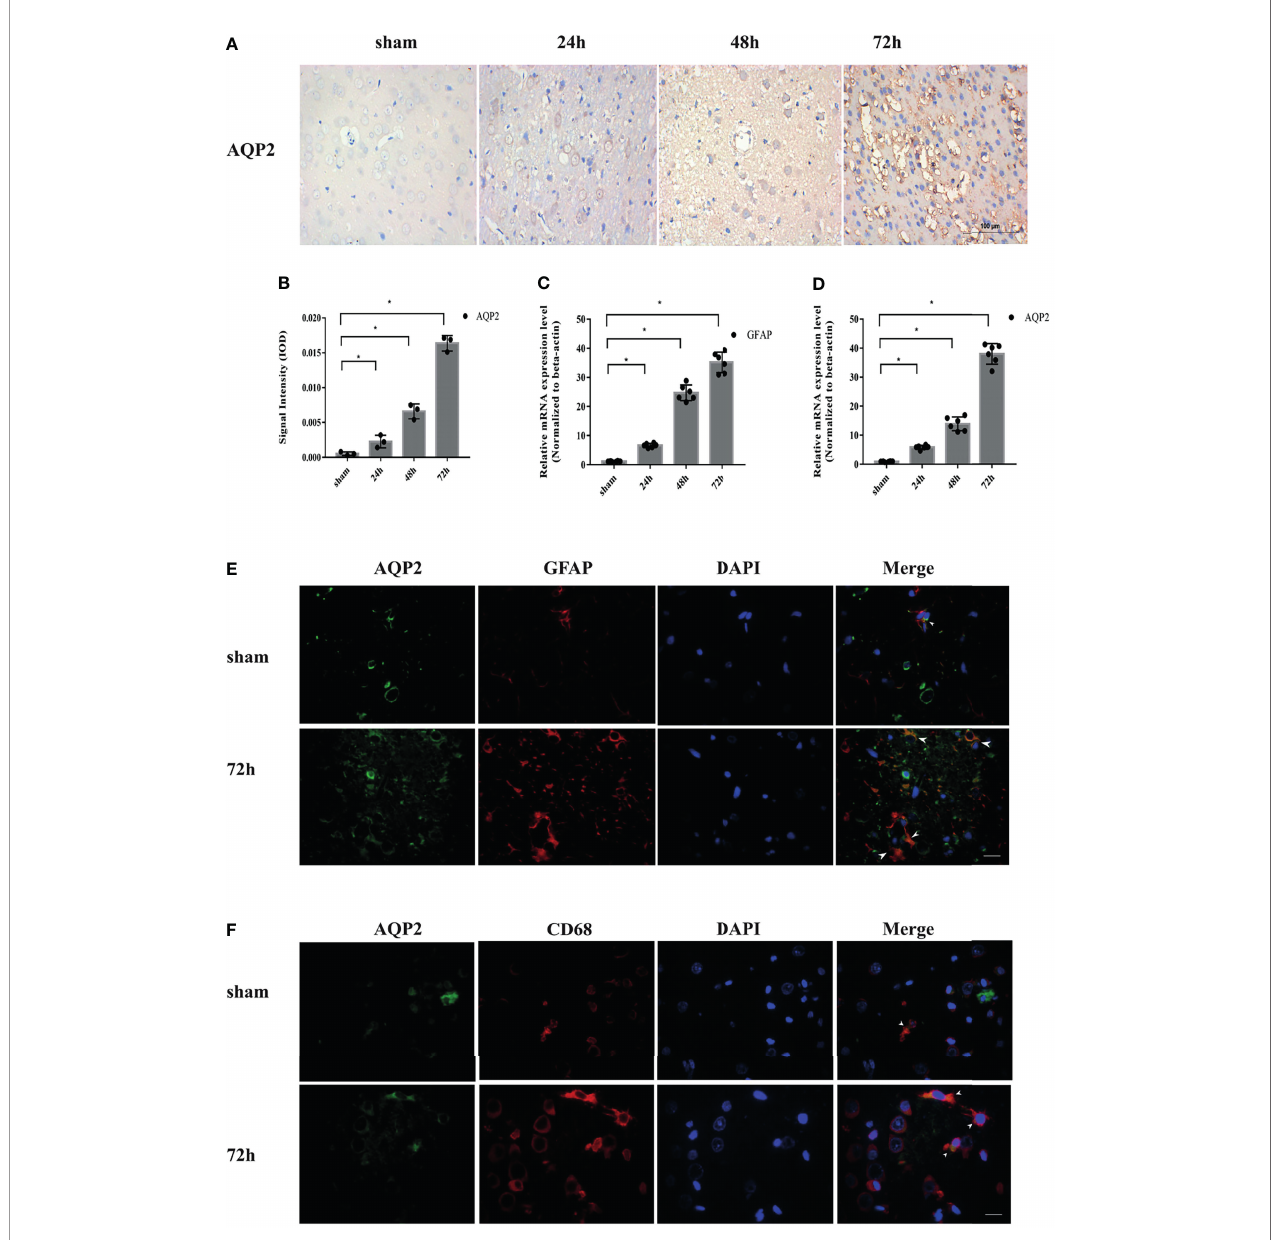
FIGURE 2 | AQP2 is highly upregulated after ICH in rat brain induced by ICH. (A) Immunohistochemical staining of AQP2 in the perihematomal area of hemorrhaged brain in rats (Scale bar=100um). (B) Data of integrated optical density (IOD) value shown as mean ± SD, were revealed a higher expression of AQP2 around hematoma in ICH groups (after 24h, 48h or 72h) compared with sham group (n=3, *p<0.05). Quanti fi cation of the relative mRNA expression of AQP2 (C) and GFAP (D) in basal ganglia region of rat brain in sham group or in perihematoma area of hemorrhaged brain after ICH (n=6, *p<0.05). Double fl uorescence staining AQP2 and astrocyte marker GFAP (E) or M1 phenotype marker CD68 (F) revealed the co-localization of AQP2 and astrocyte or microglial in basal ganglia region of rat brain in sham group or in perihematoma area of hemorrhaged brain after ICH (white arrows) (Scale